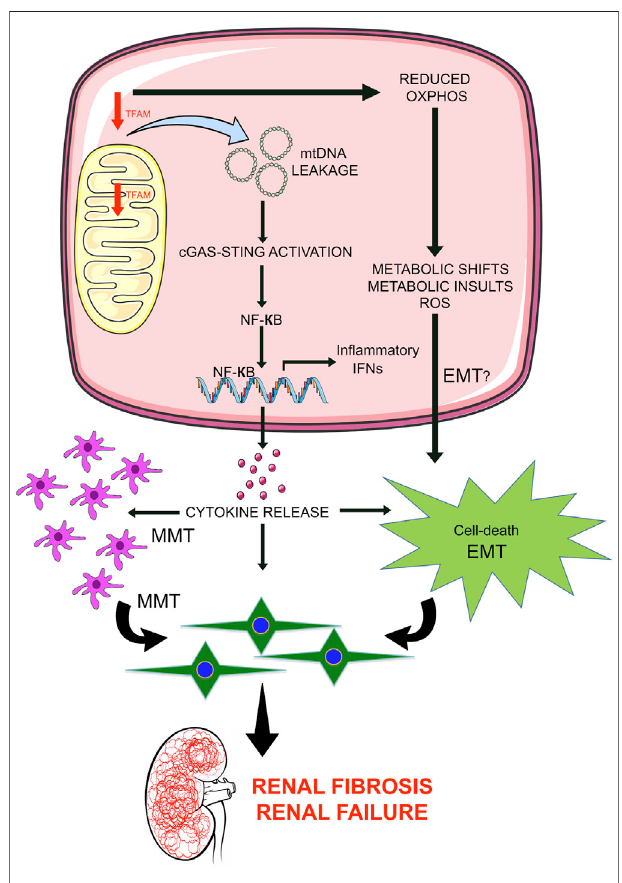
FIGURE 1 | Mitochondrial damage leads to renal in fl ammation and fi brosis. Mitochondrial transcription factor A (TFAM) is critical in the regulation of mtDNA structure, replication, and stability. Suppression of TFAM is a key event in renal fi brosis in 2ways: 1) By leadingto the leakage ofmtDNA in the cytosol which activates the STING pathway and results in transcription of NFkB-associatedcytokinesandreleaseofcytokinesoutsidethecells,induces pathological in fl ammation in tubular cells and neighboring cell types i.e. macrophages. Higher release of cytokine may in fl uence macrophage-to- mesenchymal transition and epithelial-to-mesenchymal transition and contribute to the accumulation of mesenchymal-like cells in the extracellular matrix; 2) De fi ciency of TFAM causes reduced oxidative phosphorylation that isinvolvedinthe alterationofmetabolicshifts and metabolic insults,in fl uences the reactive oxygen species level; cumulative effects may lead to epithelial-to- mesenchymal transition program and accumulations of EMT-derived myo fi broblasts in the extracellular matrix and contributes to renal injury and renal fi